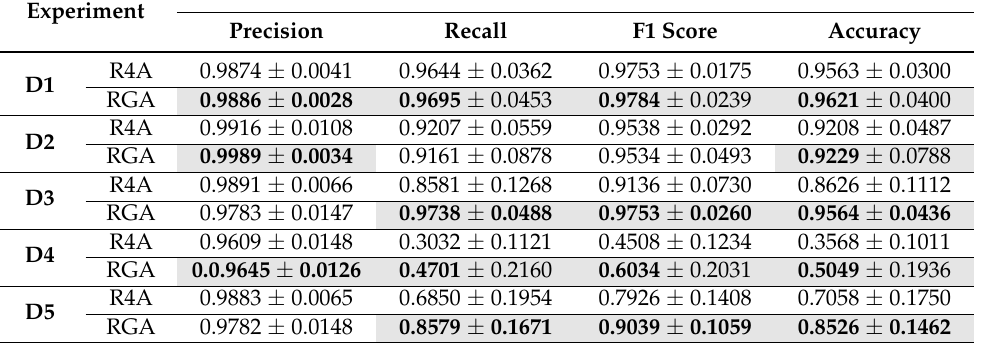
Table 17. The average results of testing each D experiment on Unseen Drone using R4A and RGA datasets. Performance of the CNN Classifier Experiment Precision Recall F1